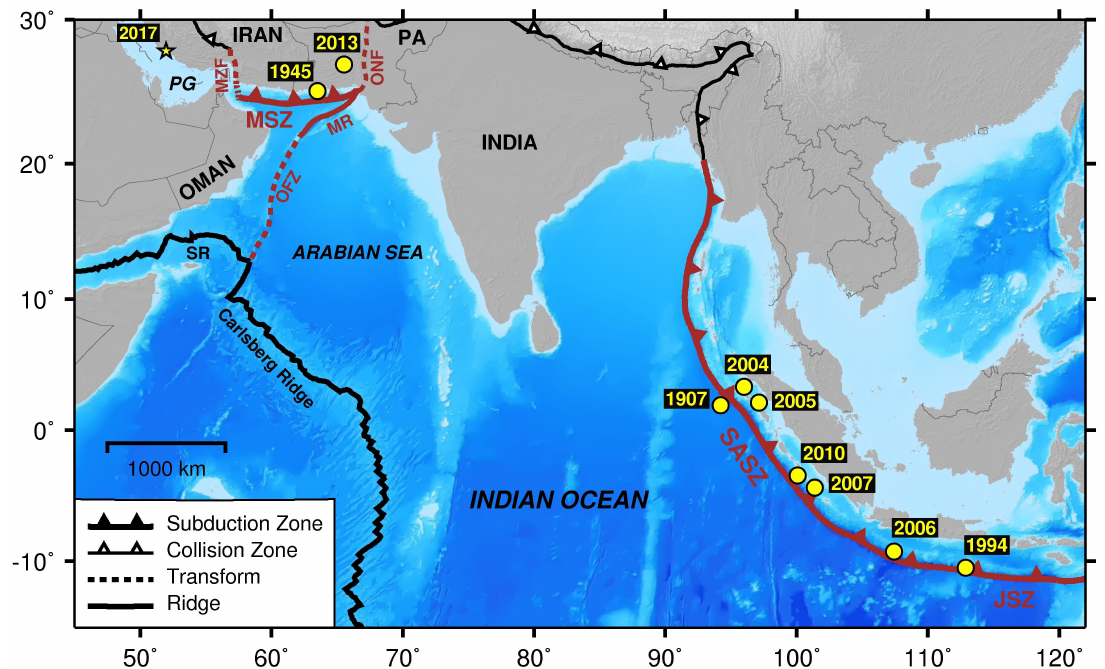
Figure 2. Near-field and Far-field sources around the Makran subduction zone (brown lines) and other plate boundaries (black lines). Yellow circles show the tectonic tsunamis in the Indian Ocean and the yellow star represents the 2017 Persian Gulf meteotsunami. PG Persian Gulf, PA Pakistan, MZF Minab-Zendan Fault, ONF Ornach-Nal Fault, MR Murray Ridge, OFZ Owen Fracture Zone, SR Sheba Ridge, SASZ Sumatra-Andaman Subduction Zone, JSZ Java Subduction